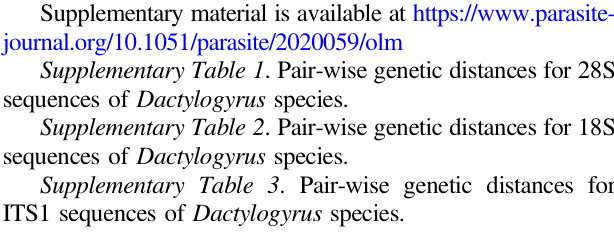
Supplementary Table 1 . Pair-wise genetic distances for 28S sequences of Dactylogyrus species. Supplementary Table 2 . Pair-wise genetic distances for 18S sequences of Dactylogyrus species. Supplementary Table 3 . Pair-wise genetic distances for ITS1 sequences of Dactylogyrus